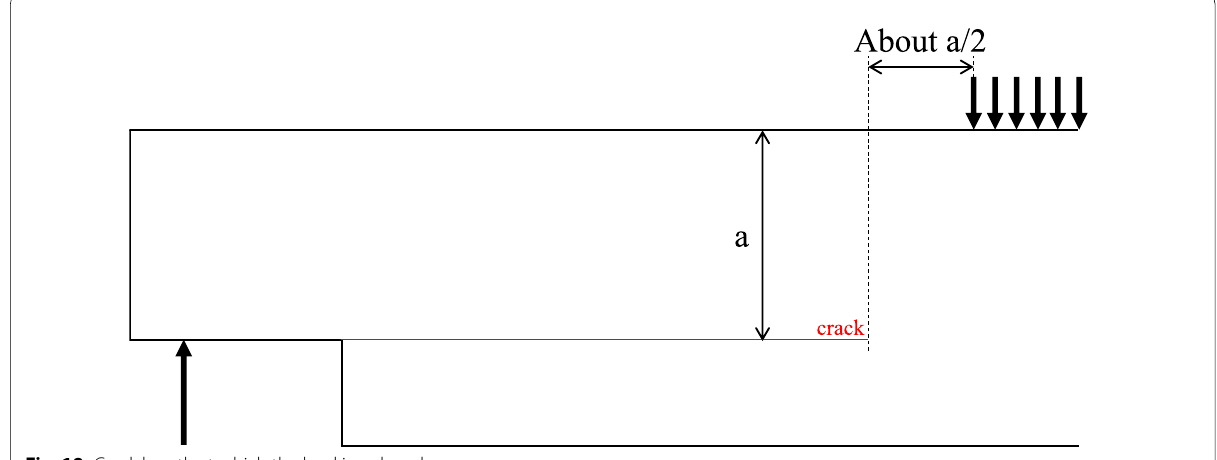
Fig. 18 Crack length at which the load is